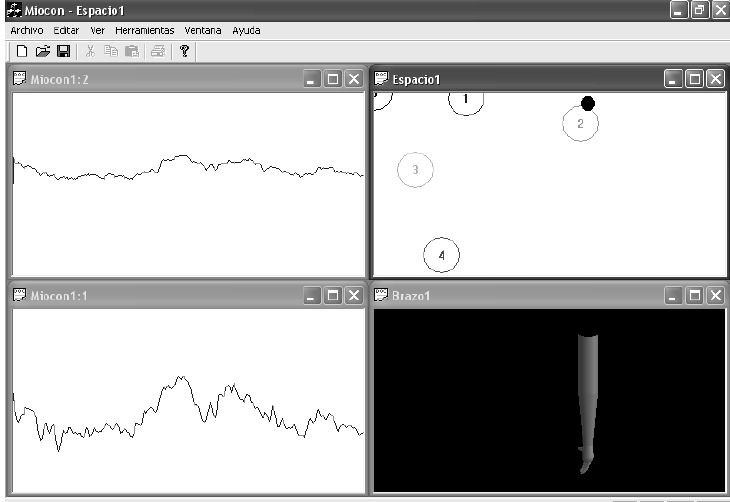
Figure 20. Increased biceps effort. Biceps MMG is at the bottom. State #2 is assigned to arm